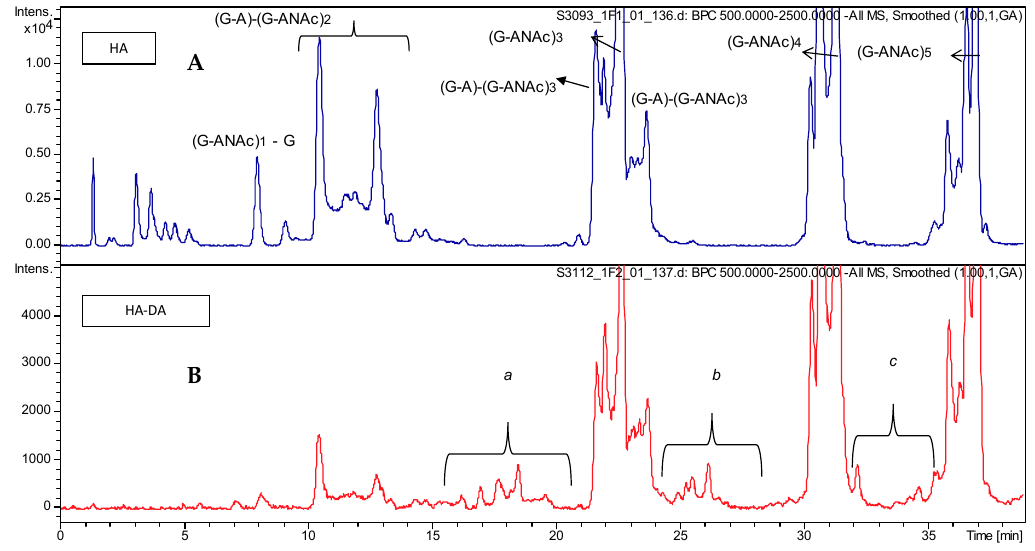
Figure 2. Partial HPLC–MS profiles: ( A ) intact hyaluronic acid (HA) and ( B ) HA-DA.